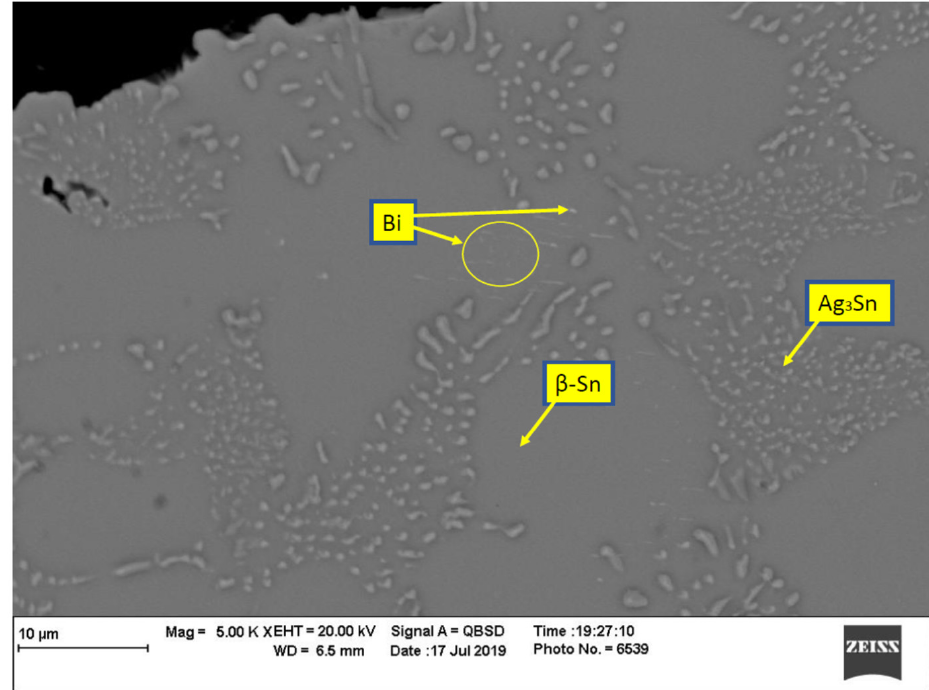
Figure 7. Microstructure of Cyclomax after thermal aging at 150 °C for 100 h.